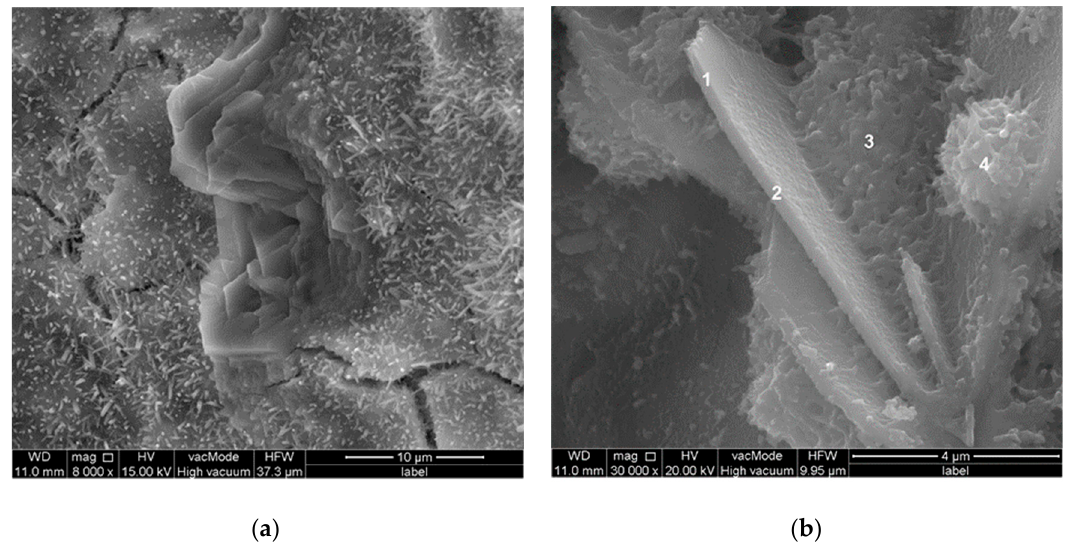
Figure 12. Microstructure of cement paste without basalt dust; ( a ) After 2 h of hydration; ( b ) After 5 h of hydration. Large hexagonal portlandite plates are visible: points 1 and 2—portlandite, points 3 and 4—C–S–H phase.